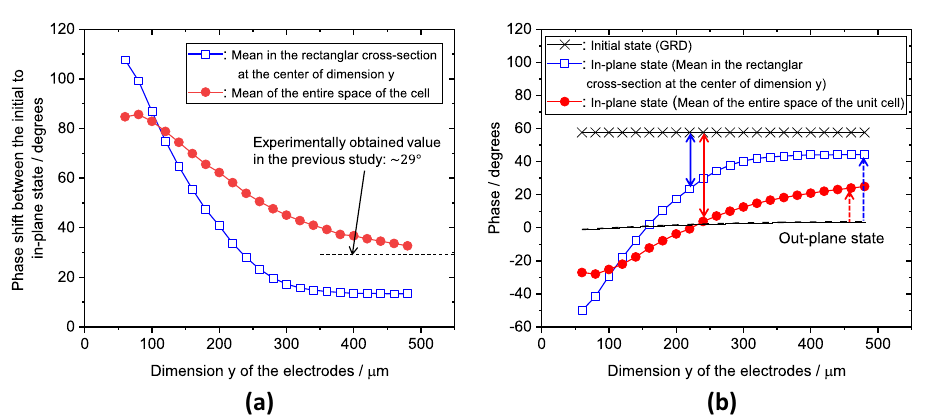
Figure 3. ( a ) Phase shifts at 2 THz from GND to the in-plane state of 100 V and ( b ) phase values of each state as functions of the electrode length y